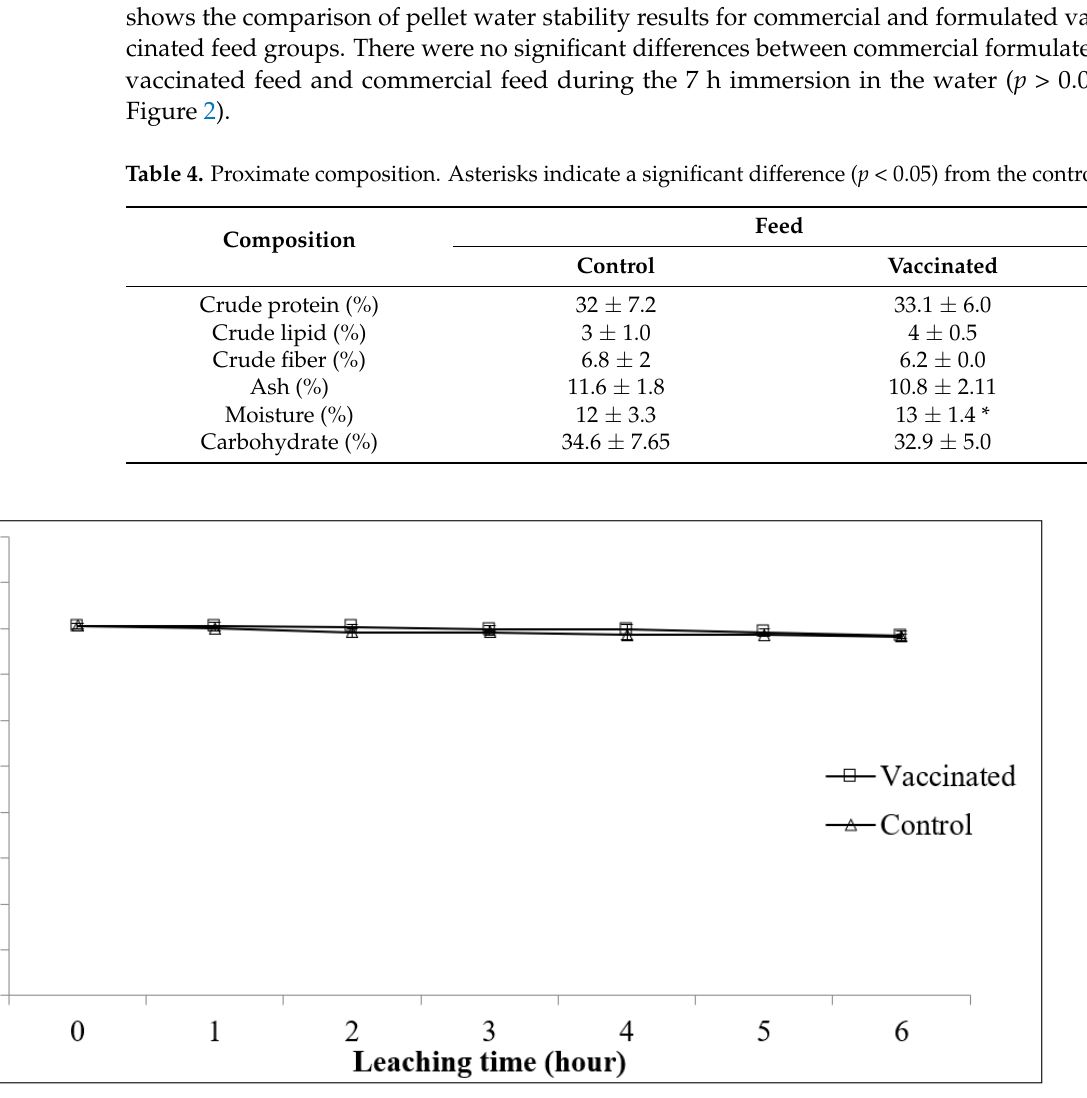
Figure 2. Percent dry matter retention (mean ± SE, n = 3) as a function of leaching time for commercial feed (control) and reformulated vaccinated feed using the static water method.